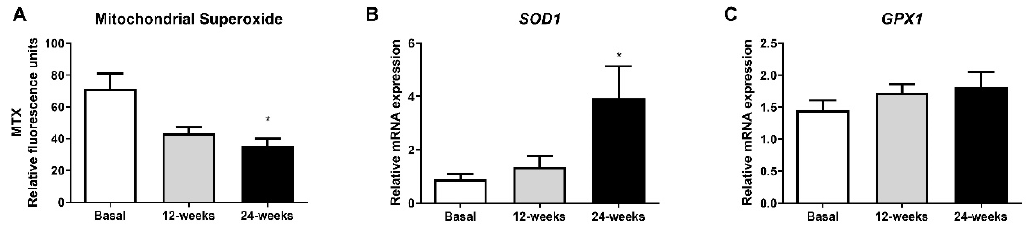
Figure 2. Effects of empagliflozin treatment on mitochondrial superoxide production and expression of SOD1 and GPX1 in leukocytes from type 2 diabetic patients at baseline and at 12 and 24 weeks of treatment. ( A ) Mitochondrial superoxide production, ( B ) mRNA expression of SOD1 , and ( C ) mRNA expression of GPX1 in human leukocytes. Data are expressed as mean ± SEM. Mitochondrial superoxide was measured as relative MitoSOX fluorescence by static cytometry, and data were normalized with respect to fluorescence at baseline. The values of SOD1 and GPX1 gene expression were normalized to mean baseline mRNA expression levels and calculated using the 2 −ΔΔ CT method. For mitochondrial superoxide production, an ANOVA followed by Dunnett’s multiple comparisons test was performed. For mRNA expression of SOD1 and GPX1 , a paired Student’s t-test was performed. * p < 0.05 vs baseline. Abbreviations: MTX, MitoSOX Red mitochondrial superoxide indicator; GPX1 , glutathione peroxidase 1; SOD1 , superoxide dismutase 1.